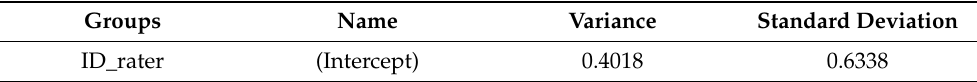
Table 2. Mixed-effects model for perceived accentedness in Russian: random-effects factor.